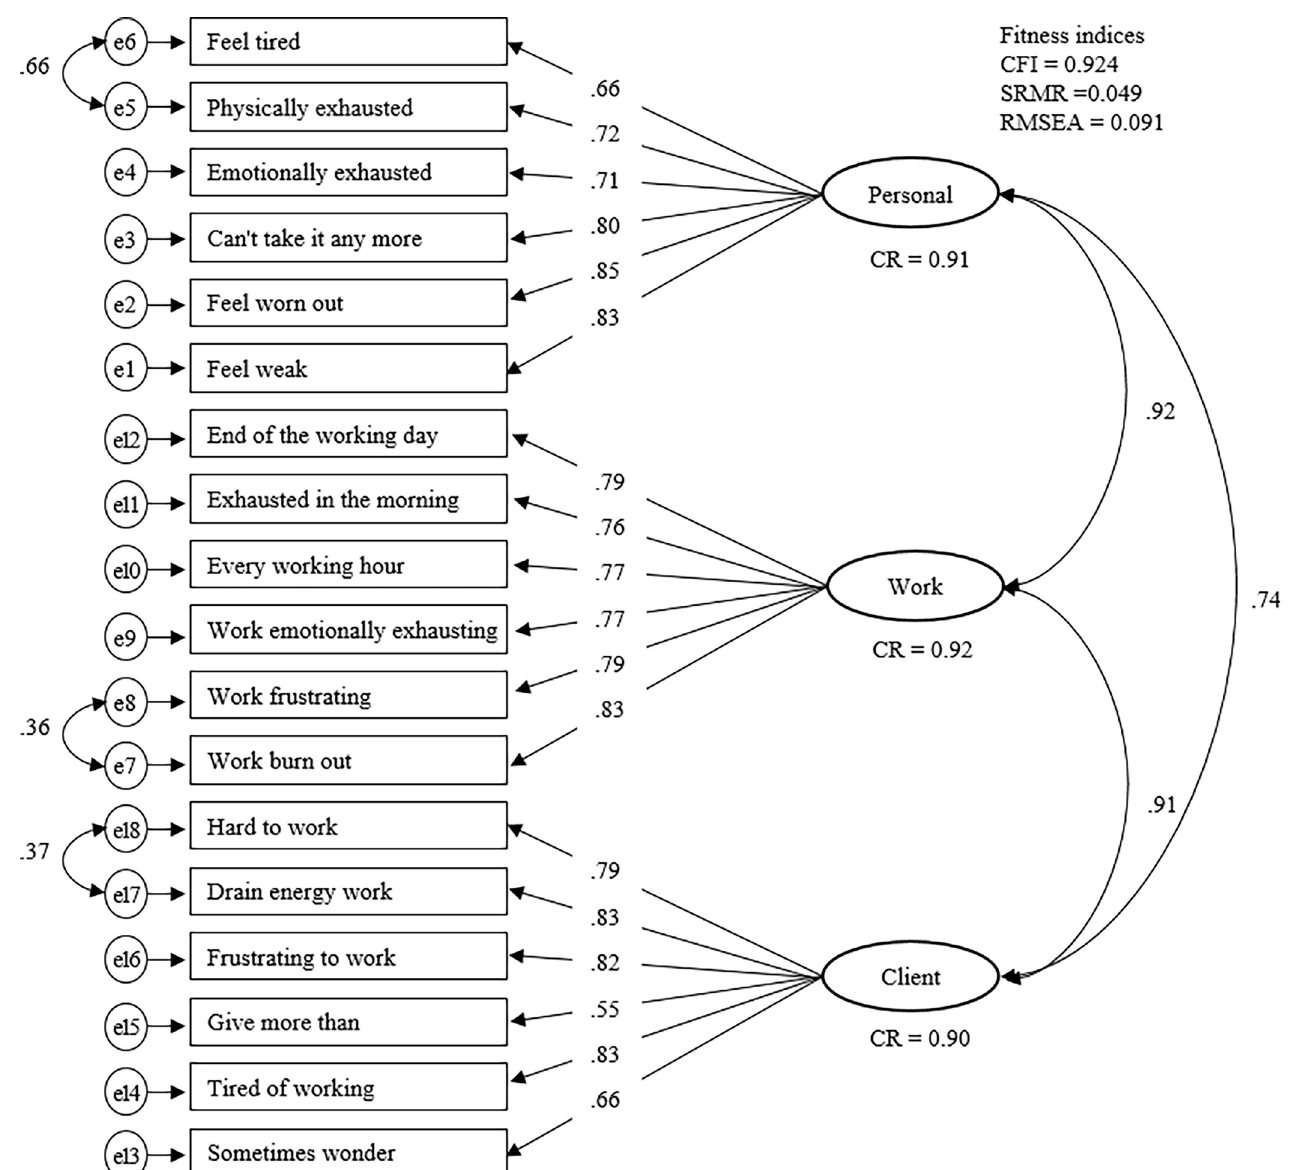
Fig 1. Results of the refined K-CBI model for Korean care workers. Notes : CFI: comparative fit index; SRMR: standardized root mean square residual; RMSEA: root mean square error of approximation; CR = composite reliability.